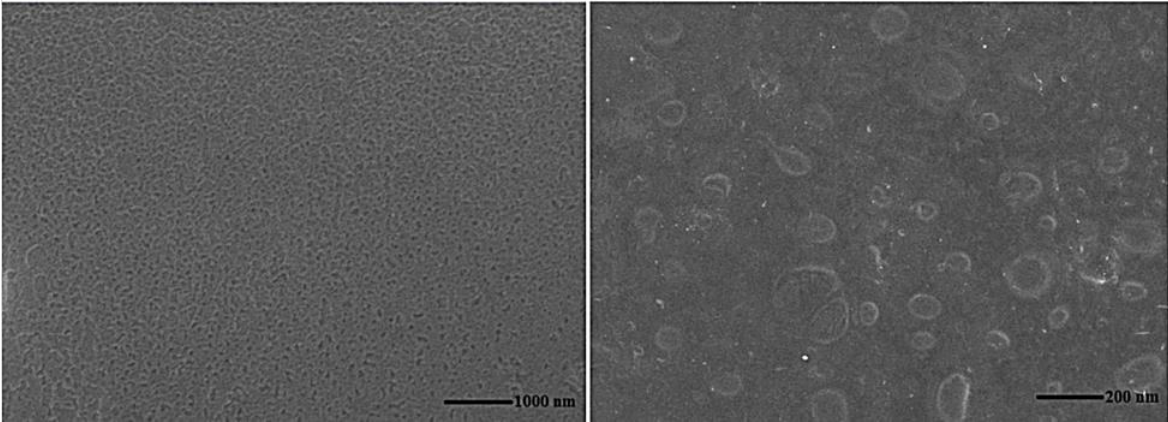
Figure 3. Scanning electron microscope images of oral tadalafil niosomal